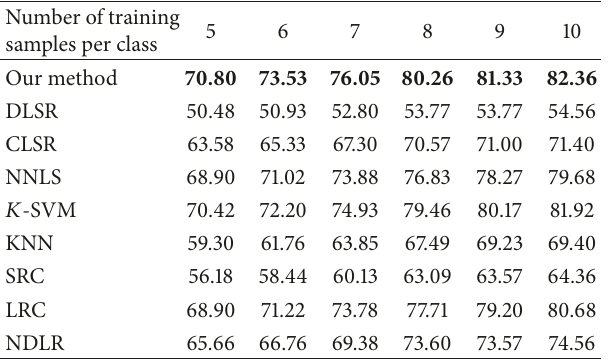
Table 2: Accuracies (%) of different methods on the FERET